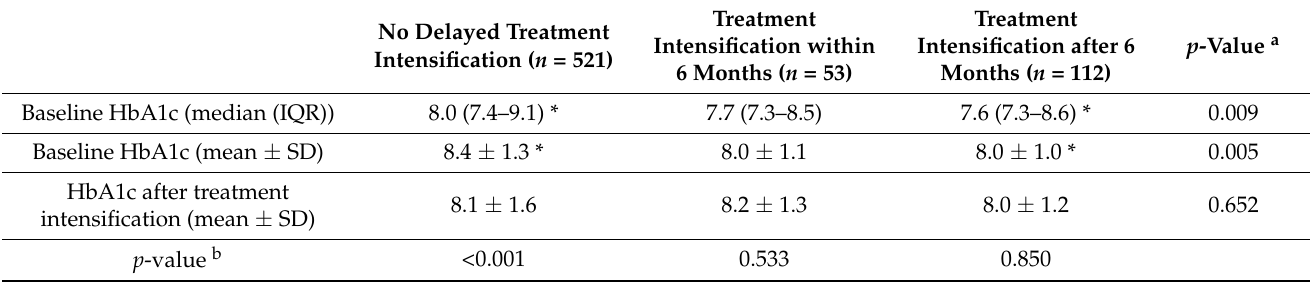
Table 4. The difference in mean HbA1c between baseline HbA1c and HbA1c after treatment